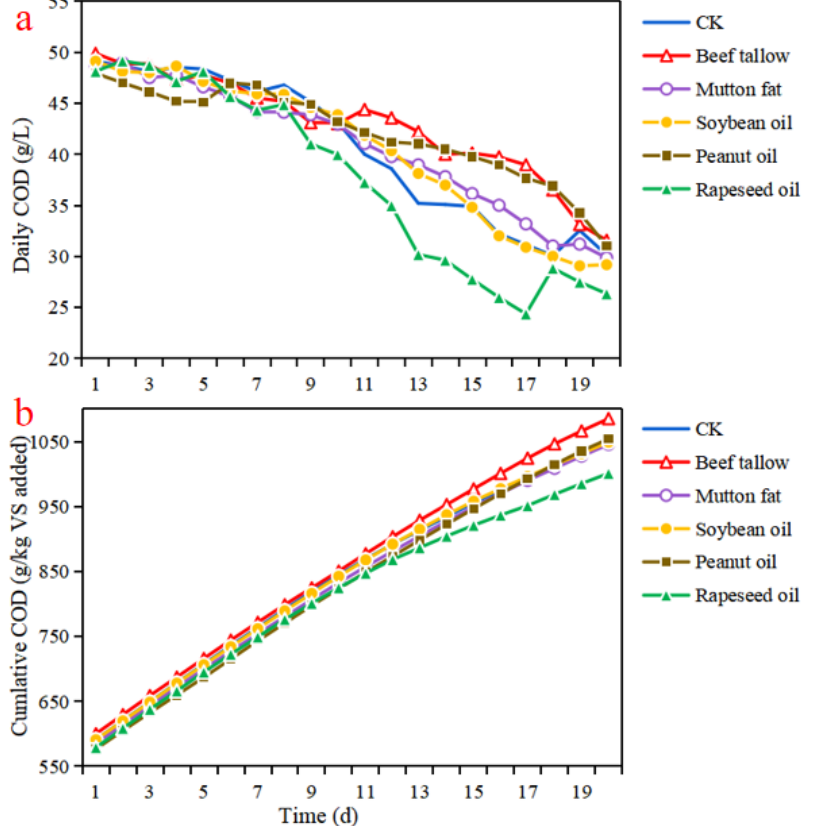
Figure 2. ( a ) Daily and ( b ) cumulative COD production in treatments with different types of li-